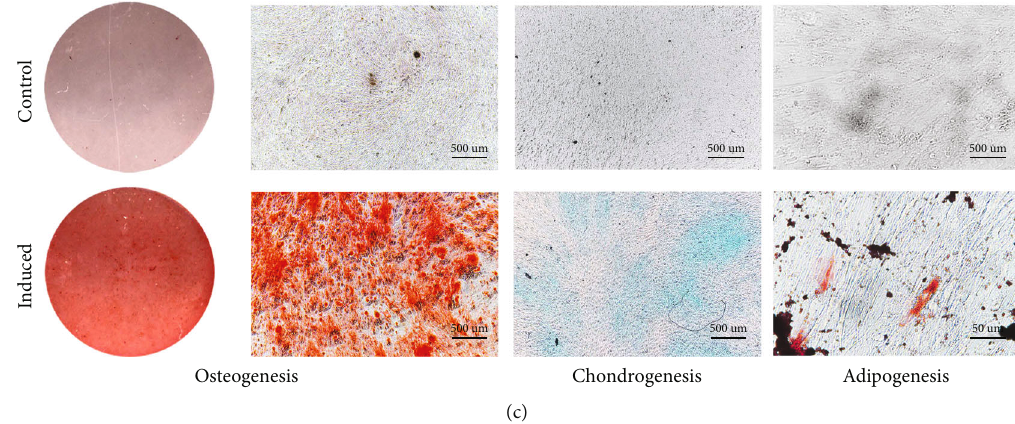
Figure 1: Isolation and identi fi cation of hDPSCs. (a) Morphology of hDPSCs. (b) Surface antigens of hDPSCs were assessed by fl ow cytometry. (c) Osteogenic capacity was con fi rmed with positive alizarin red staining. Adipogenic capacity was veri fi ed with positive oil red O staining. Chondrogenic capacity was determined by alcian blue staining. Scale bar = 500 μ